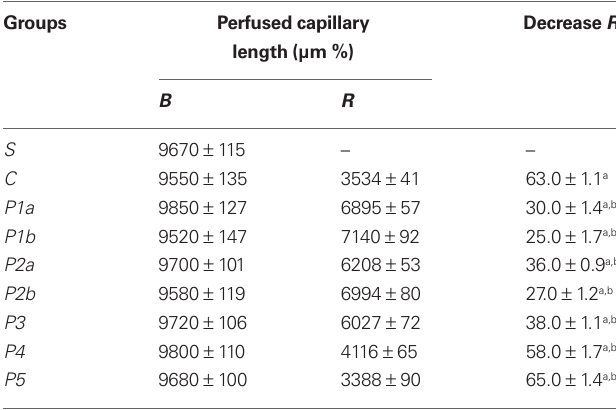
Table 2 | The perfused capillary length under baseline conditions ( B ) and percent changes at the end of reperfusion ( R ) in the experimental